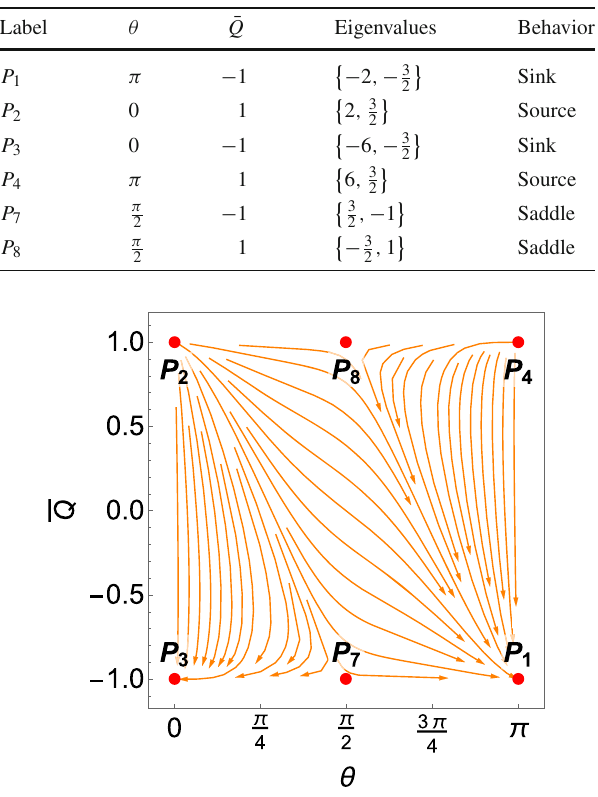
Fig. 1 Orbits in the invariant set (θ, ¯ Q ) , with dynamics given by (144)